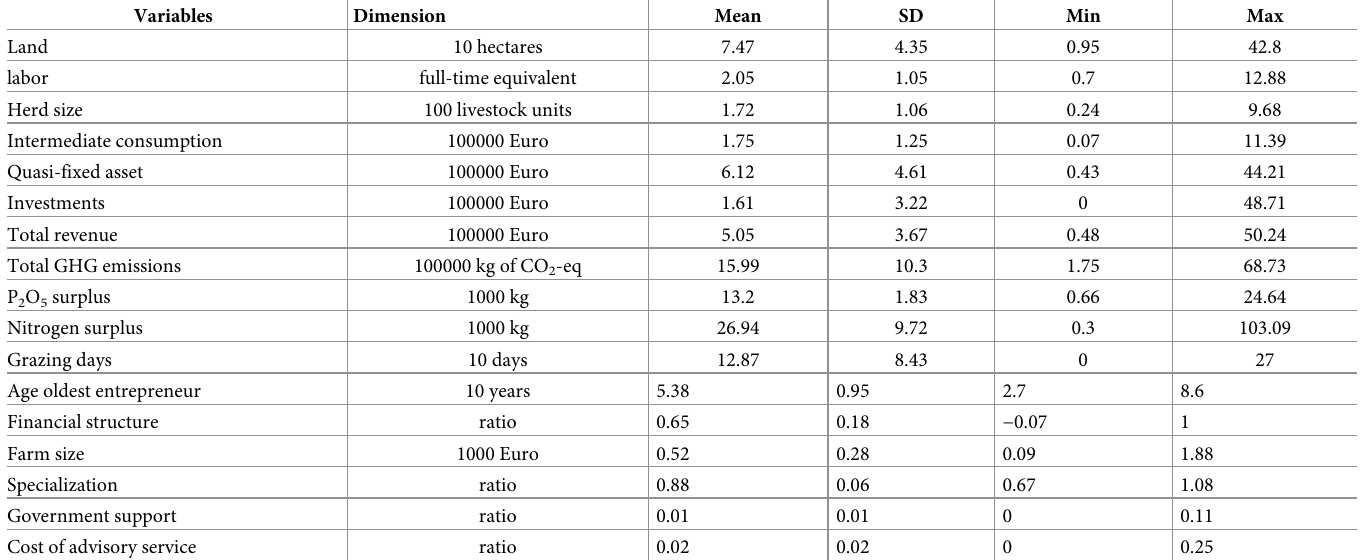
Table 1. Descriptive statistics of the dairy farms (average over the period